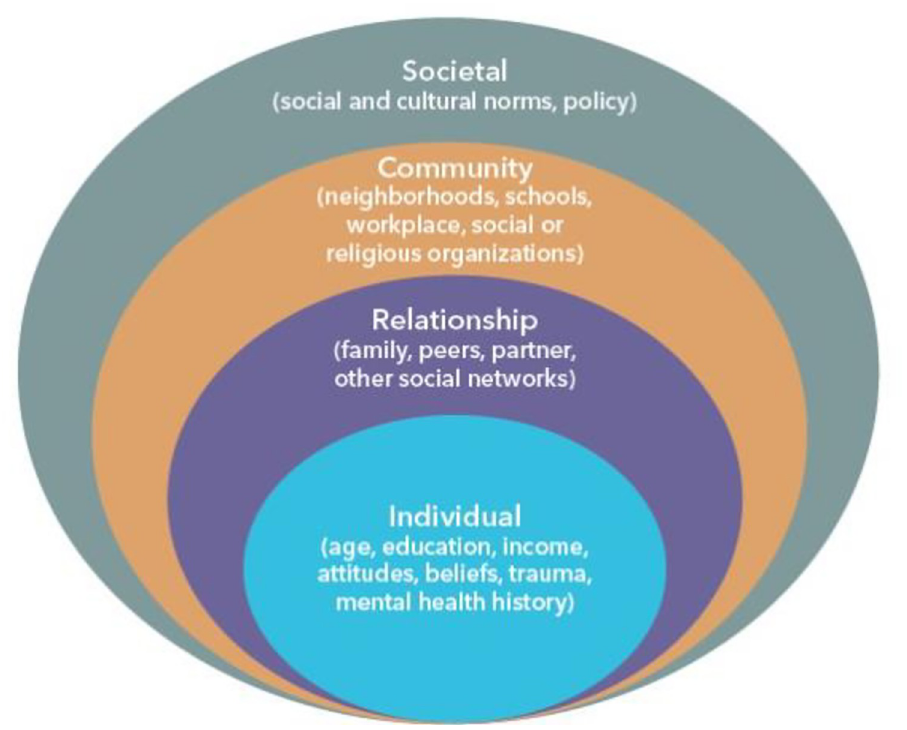
Fig 1. Social ecological